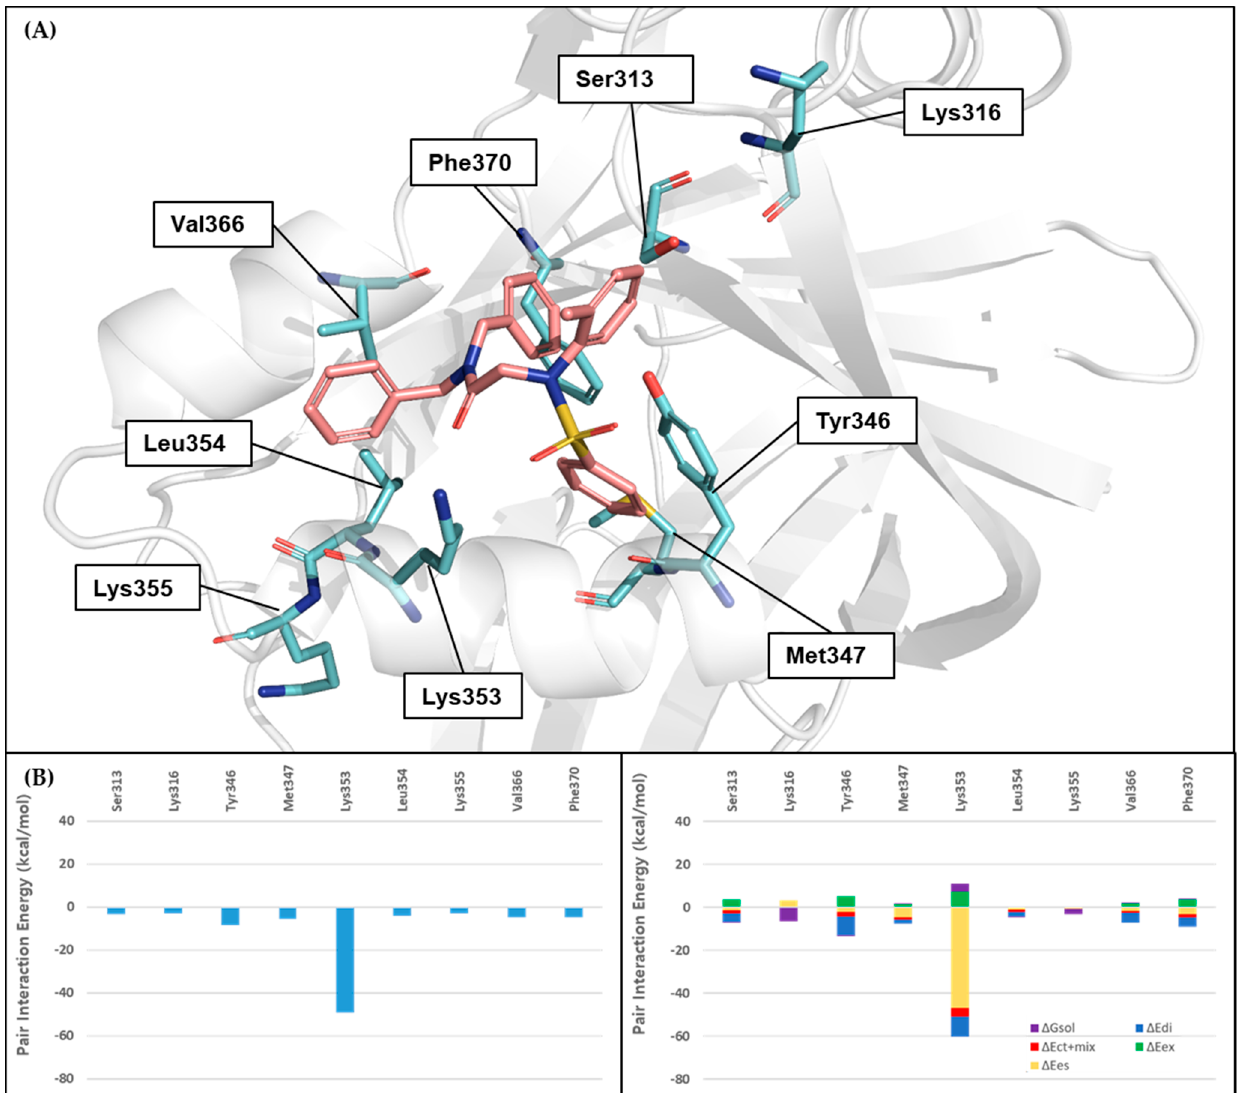
Figure 11. FMO results for BY03 in complex with interface 2 in TEAD1. PIEDA results of BY01 and BY02 are shown in Table S4 and S5, respectively. ( A ) The structure of BY03 binding to the interface 2 of TEAD1. The ligand is shown in light pink, the protein residues are shown in cyan, and the nitrogen and oxygen atoms are shown in blue and red, respectively. ( B ) The left bar plot describes the PIEs of the significant residues in the interface2 of TEAD1, while the right bar plot describes the PIEDA of these critical interactions. The electrostatic, exchange repulsion, charge transfer with higher order mixed term, dispersion, and solvation energy terms are shown in yellow, green, red, blue and purple, respectively.